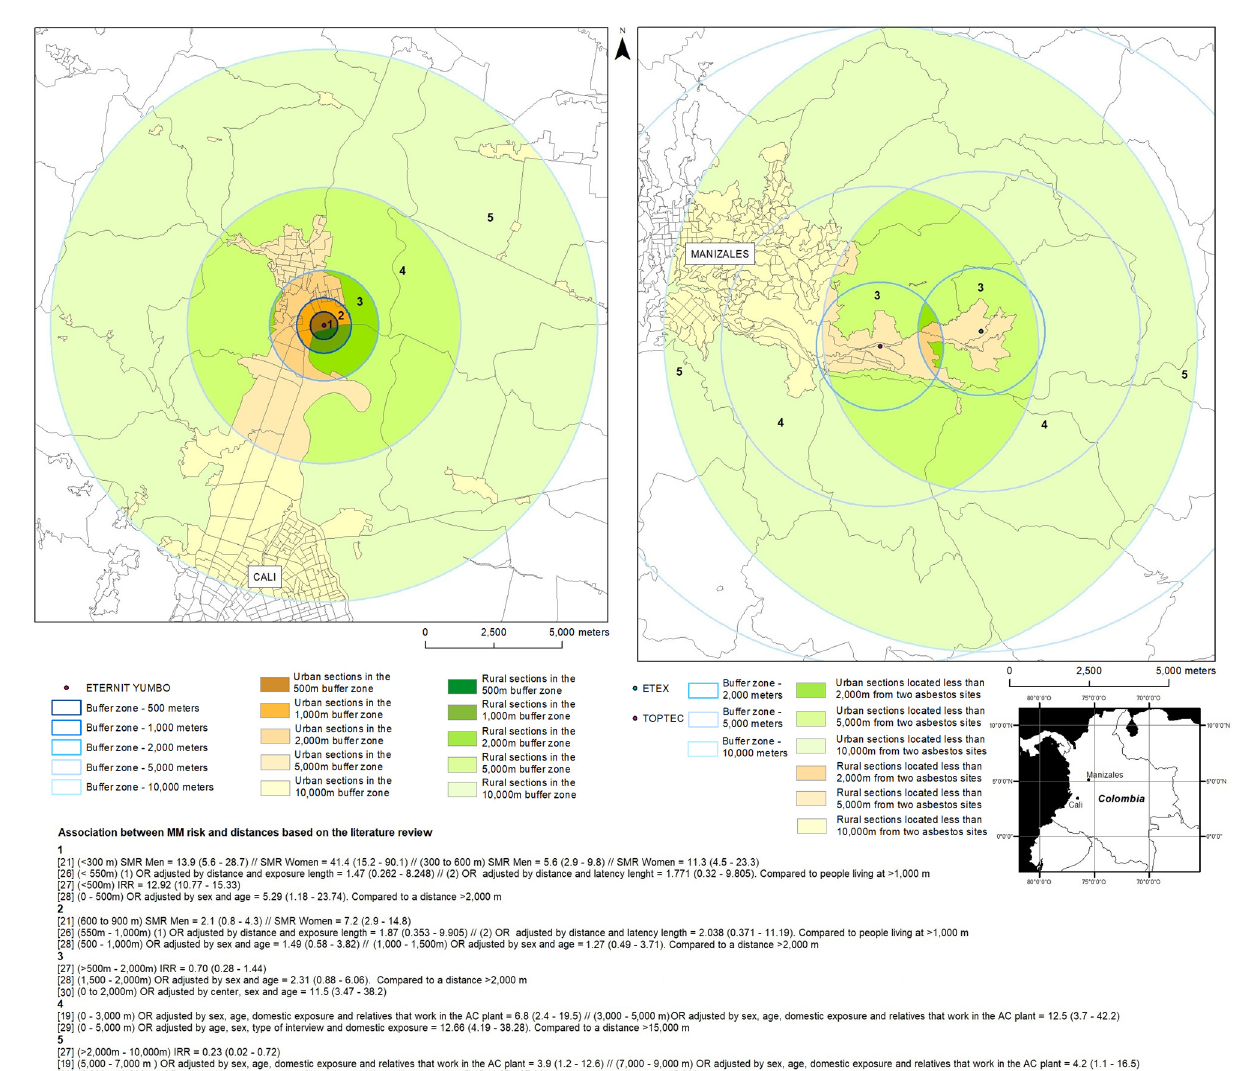
Figure 1. Illustration of the intersection between the buffer zones, based on the relationship between “distance bands and MM risk” extracted from the literature, and the polygons of the MGN (left—Eternit, Yumbo, 2018), highlighting the sectors potentially impacted by atmospheric releases from two sites (right—Etex and Toptec—Manizales, Caldas, 2018).